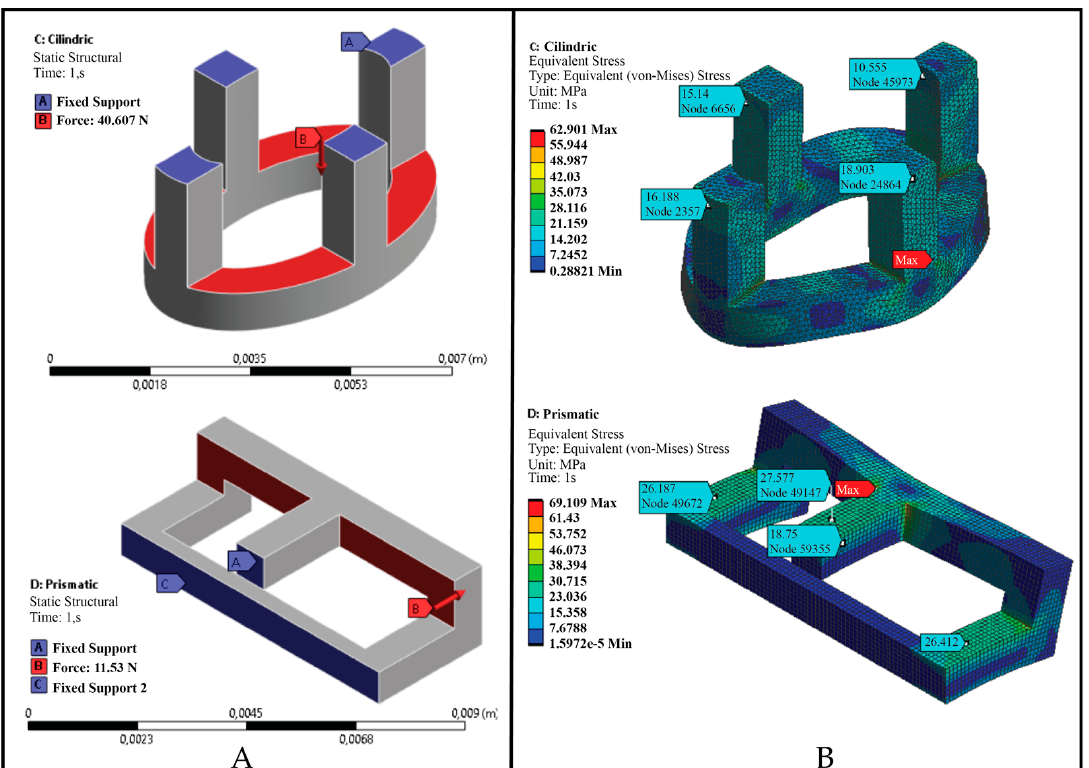
Figure 10. Modeling using CAE software for cylindrical and prismatic elements. ( A ) pre-processing; and ( B ) equivalent von Mises stress